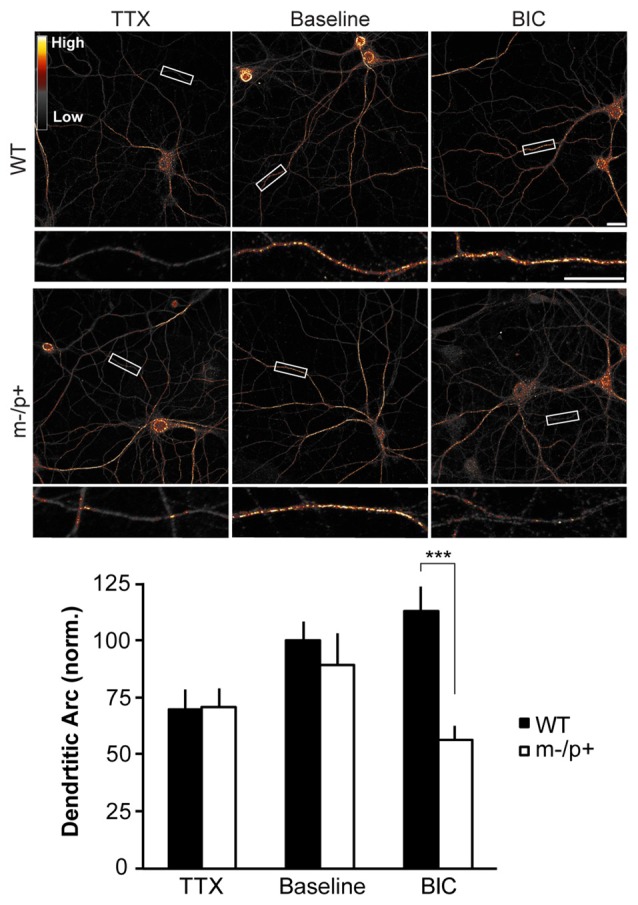
Homeostatic expression of Arc is disrupted in Ube3am−/p+ neurons. Cultured hippocampal Ube3am−/p+ and WT neurons at DIV19–21 were treated with either TTX or BIC for 24 h to induce homeostatic scaling. Neurons were immunostained for Arc and dendritic expression analyzed (n = 15 neurons/group, two dendrites/neuron). BIC and TTX induced changes in Arc expression in WT neurons, with an increase in Arc expression with BIC and a decrease with TTX. BIC-induced scaling was absent, however, in Ube3am−/p+ neurons, and Arc levels were significantly lower than in WT neurons. Scale bar = 10 μm. ***P < 0.001.